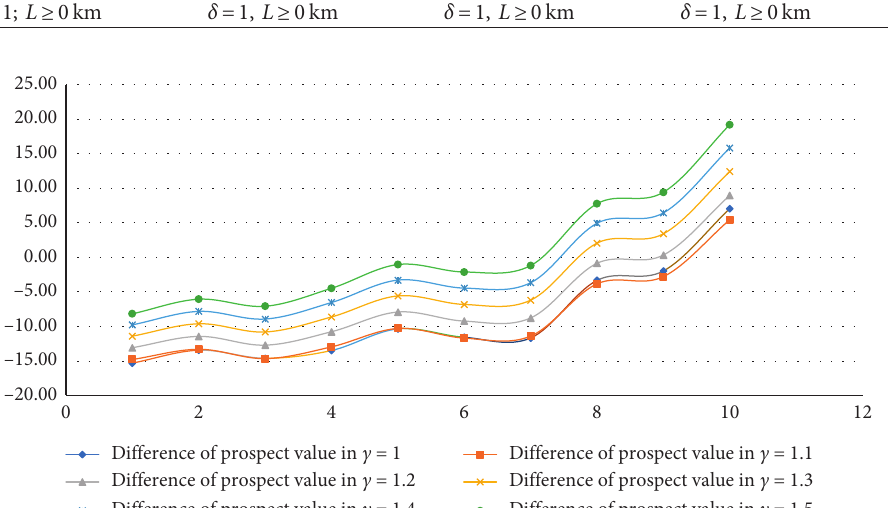
Figure 6: t � 5 and δ � 1.5. The difference of prospect value between the drone and the